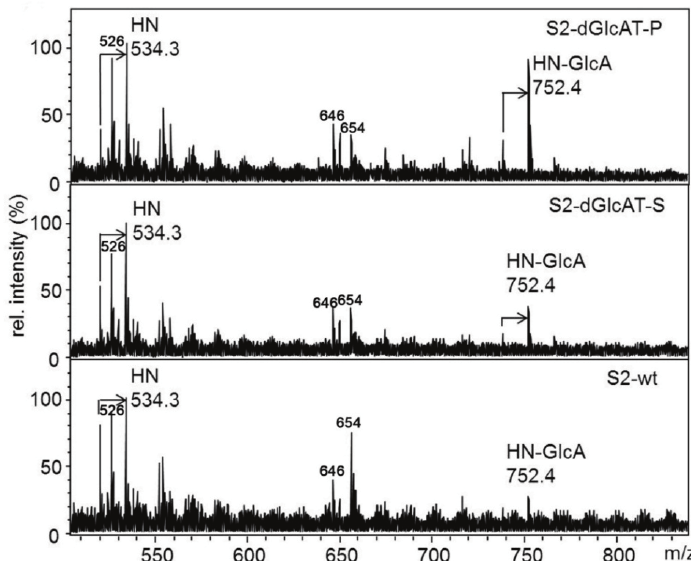
Figure 2. MALDI-MS of permethylated O -glycans from S2-cell lysates. In comparison to wt cells (lower panel), S2 cells overexpressing dGlcAT-P (upper panel) show an increase in non-sulfated glucuronyl-T-antigen expression (HN-GlcA + Na, m / z 752) relative to the precursor T-antigen (HN+Na, m / z 534), while no difference is observed in dGlcAT-S overexpressing cells (middle panel). The arrows indicate signals corresponding to mono-undermethylated proton adducts (MNa-36). Other mass signals in the range up to 1000 Da refer to matrix-derived ions. Short notation of glycan